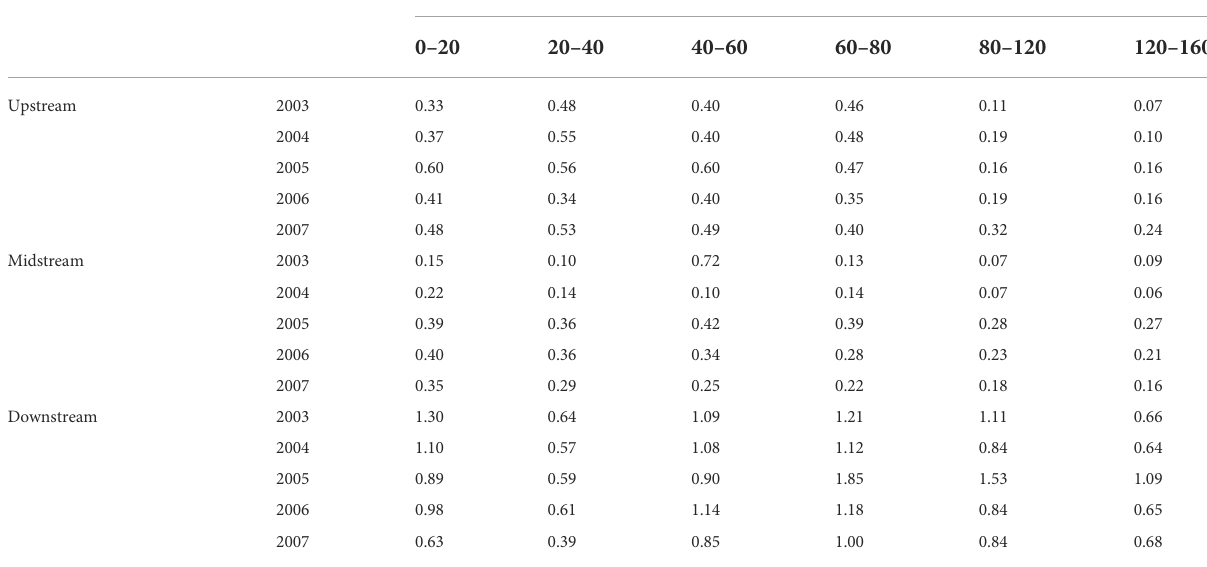
TABLE 2 Variation coef fi cient of soil moisture content.